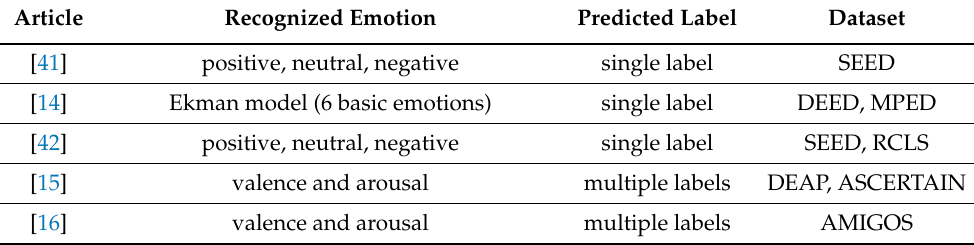
Table 1. Recognized emotions from